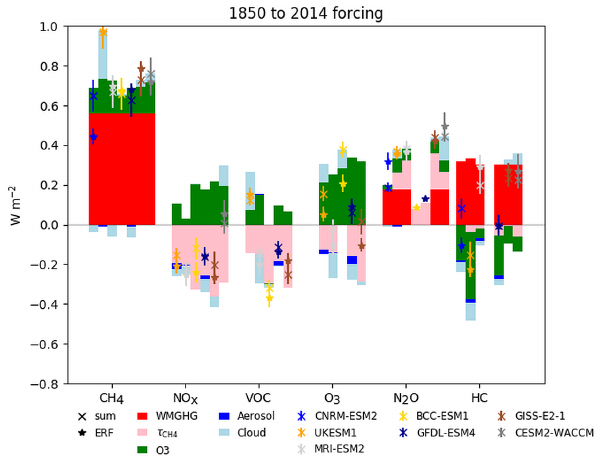
Figure 9. Changes in methane lifetime (%), for each experiment. Uncertainties for individual models are errors on the mean from interannual variability. Uncertainties for the multi-model mean are standard deviations across models.